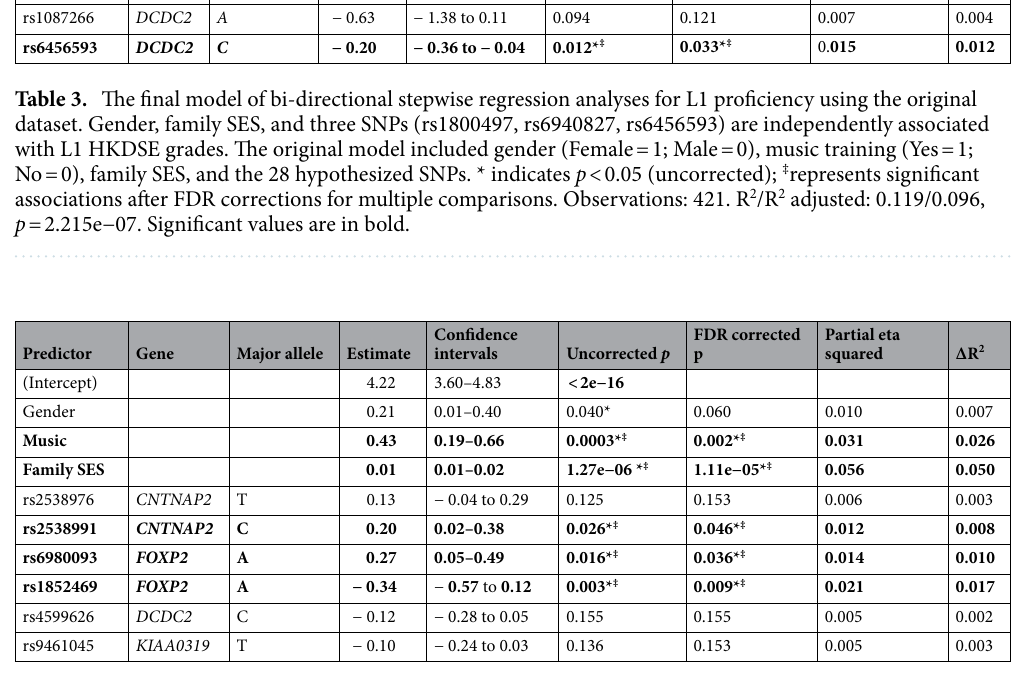
Table 4. The final model of bi-directional stepwise regression analyses for L2 proficiency. Music training, family SES, and three SNPs on CNTNAP2 (rs2538991) and FOXP2 (rs6980093, rs1852469) are independently associated with L2 HKDSE grades. The original model included gender (Female = 1; Male = 0), music (Yes = 1; No = 0), family SES, and the 28 hypothesized SNPs. * indicates p < 0.05 (uncorrected); ‡ represents significant associations after FDR corrections for multiple comparisons. Observations: 421. R 2 /R 2 adjusted: 0.138/0.119, p = 6.72e−10. Significant values are in bold.